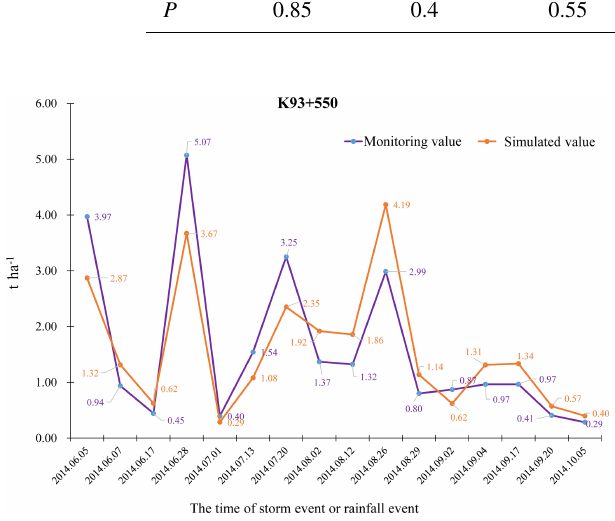
Figure 11. Comparison of model prediction and monitoring results (K93+550).